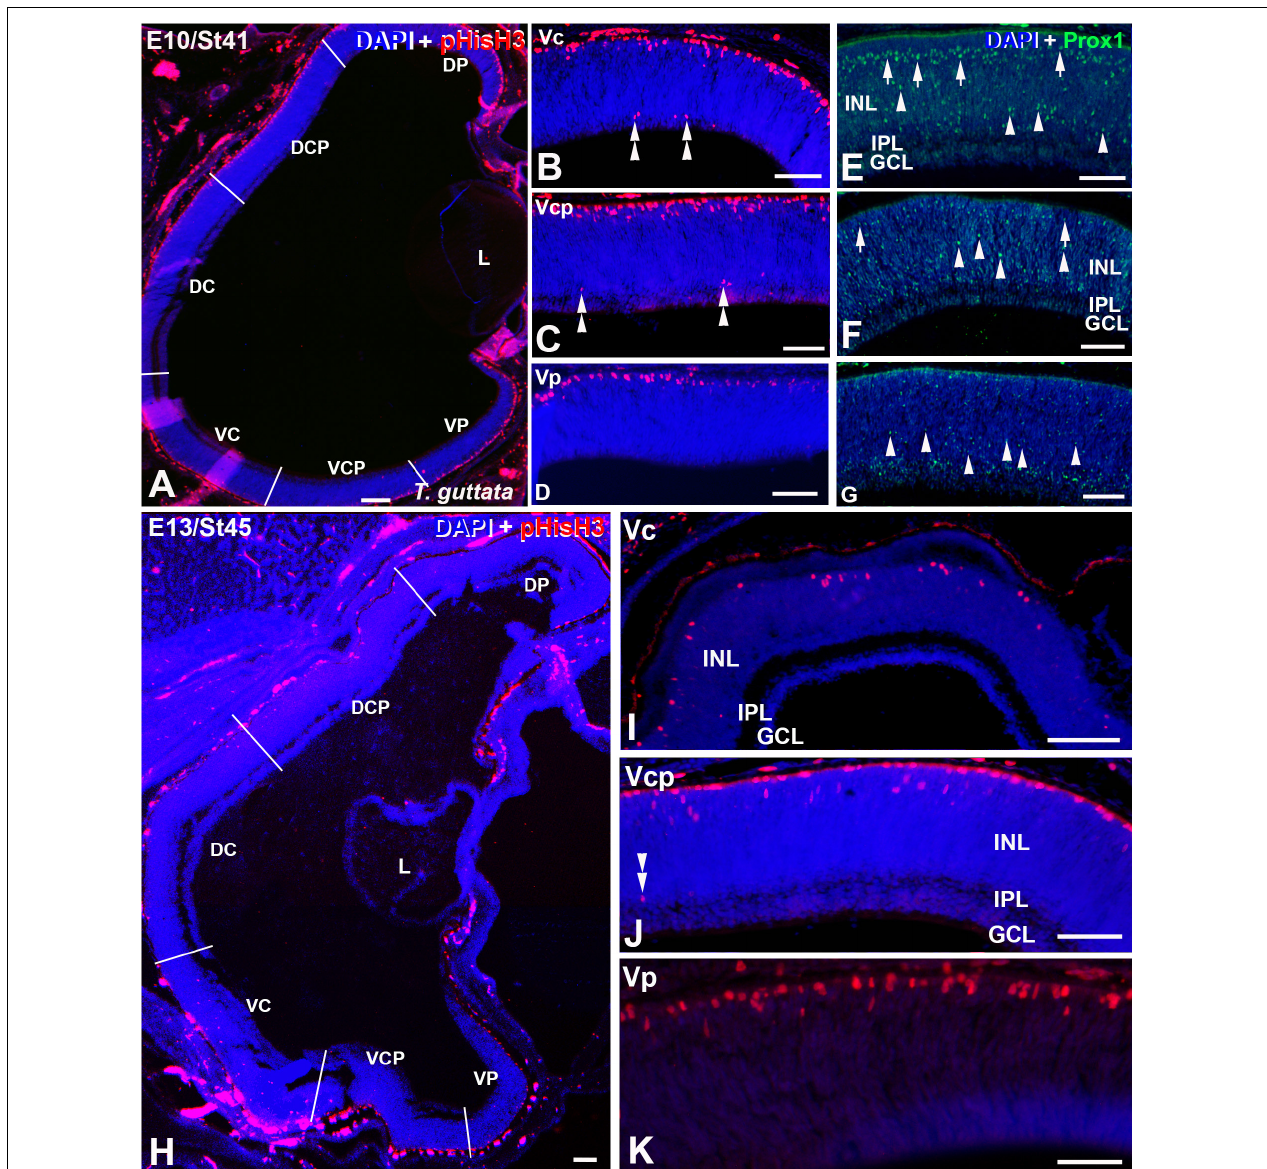
FIGURE 5 | Retinal cryosections of T. guttata at E10 (St41) (A–G) and E13 (St45) (H–K) immunolabelled with antibodies against pHisH3 (A–D,H–K) and Prox1 (E–G) . Cryosections were counterstained with DAPI. (A–D) Non-apical mitoses were restricted to the V retinal half (double arrowheads), mainly to the Vc and Vcp sectors (B,C) . Prox1 immunoreactivity located in the presumptive horizontal cell layer progressively decreased from the Vc to the Vp sector [arrows in panels (E,F) ]. In contrast, Prox1 immunoreactivity in more internal regions progressively increased from the Vc to the Vp region [arrowheads in panels (E–G) ]. (H–K) Non-apical mitoses were mainly distributed in the Vc and Vcp sectors (double arrowheads). Notice that the pHisH3-immunoreactive figures located in the apical region of the E13 retina are less numerous than that observed at previous stages. Abbreviations: GCL, ganglion cell layer; INL, inner nuclear layer; IPL, inner plexiform layer; NbL, Neuroblastic layer. Scale bars: 50 µ m in panels (A–I) ; 25 µ m in panels (J,K) .